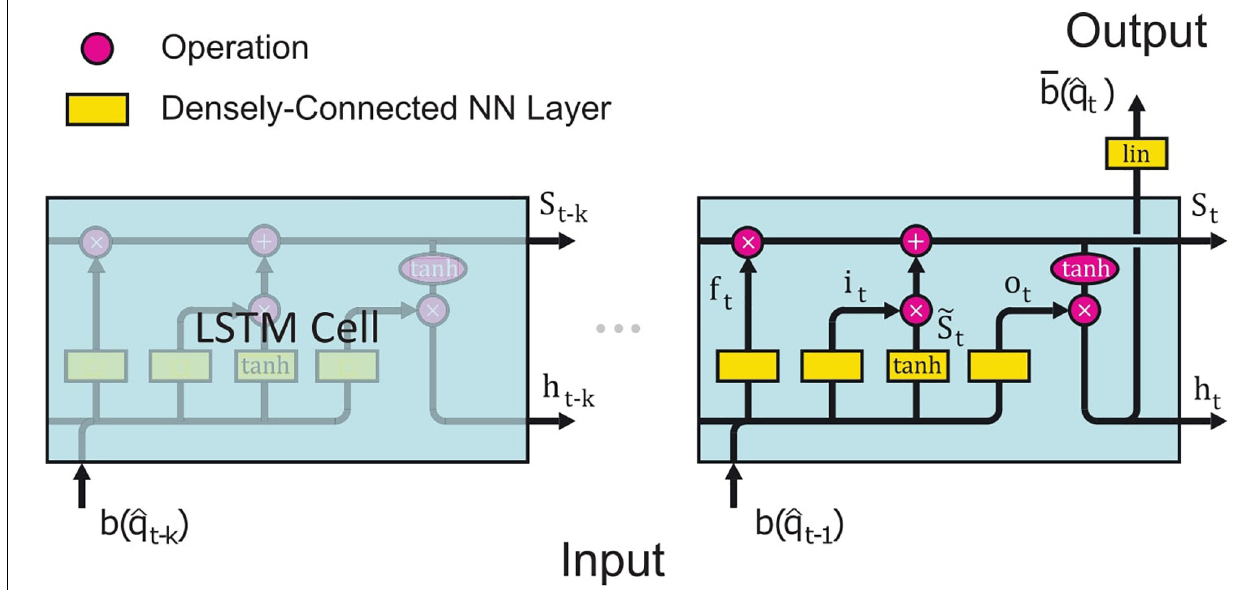
FIGURE 2 | Schematic illustration of the LSTM network architecture. The basic structure encompasses k LSTM cells connected in series, where the cell i receives input from the previous cell in the form of the cell state S i − 1 (Eq. 18) and hidden cell state h i − 1 (Eq. 19), and then ends with a fully connected NN layer, which outputs the prediction of the LSTM network ¯ b . Apart from the input from the previous cell, each LSTM cell also receives input from the stack of previous estimates b i . Each LSTM cell consists of four fully connected NN layers (yellow boxes) which all have the same complexity d = 1,280: (i) f t (Eq. 14), the “forget gate layer,” is an NN with a sigmoid activation function. This layer gates the previous cell states 0 ≤ S t − 1 ≤ 1 (Eq. 18) depending on h t − 1 (Eq. 19) and the previous estimate b (cid:0) ˆ q t − 1 (cid:1) (Eq. 20). (ii) i t (Eq. 15), the “input gate layer,” is also a sigmoid layer with the same inputs as f t . It determines which cell state values to update. (iii) ˜ S t (Eq. 16) is the subsequent fully connected NN layer with a tanh activation function, which creates candidate cell state values gated by i t . The state S t of the current cell is formed by “forgetting” outdated information of the previous cell state S t − 1 through a multiplication with f t followed by an update with the gated new cell state candidates i t ∗ ˜ S t . (iv) o t is a fully connected NN layer activated by a sigmoid function. This layer decides which cell states to output. It gates the tanh scaled cell state S t . Because all NN layers have the same number of neurons d except for the final output layer, S t and h t are both d -dimensional vectors, see section “Contextual Estimates” for more details. The illustration is adapted from Olah